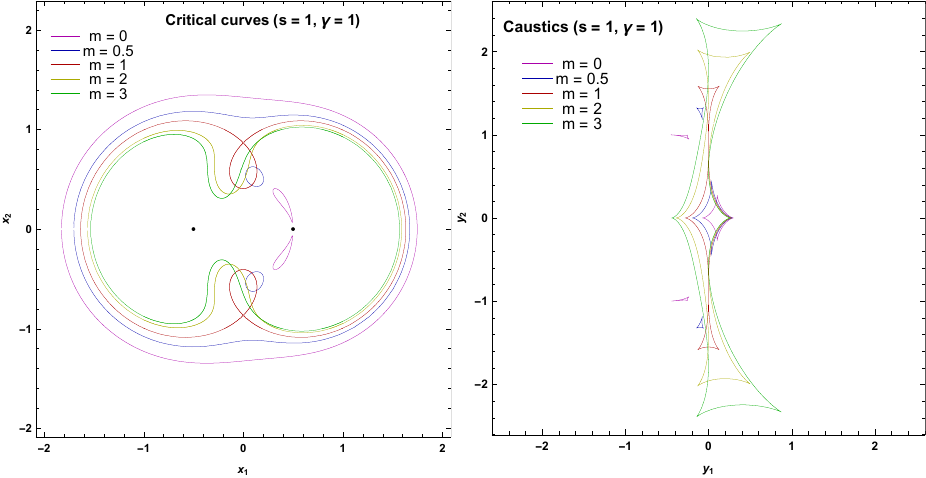
Figure 4. Critical curves and caustics in the equal-strength binary, close-intermediate